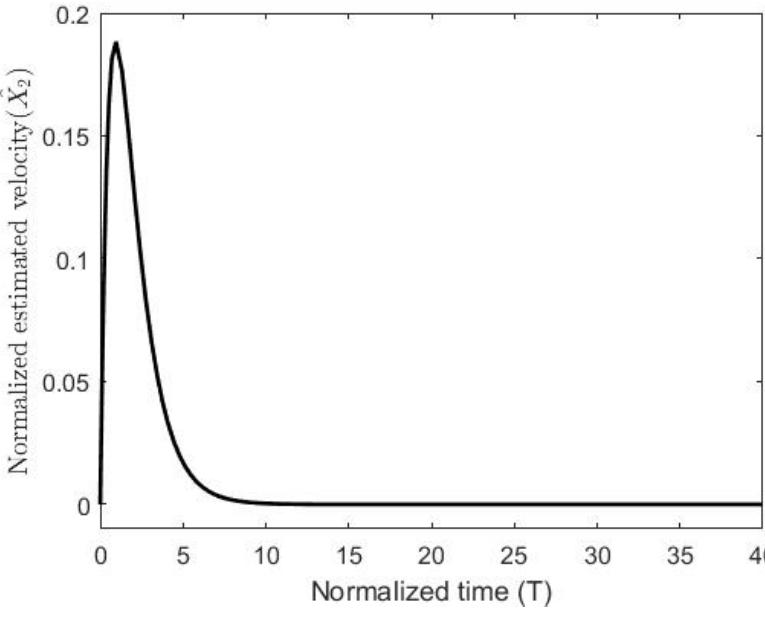
Figure 7. The normalized estimated velocity with the coupling constant at a gap distance of 0.5.